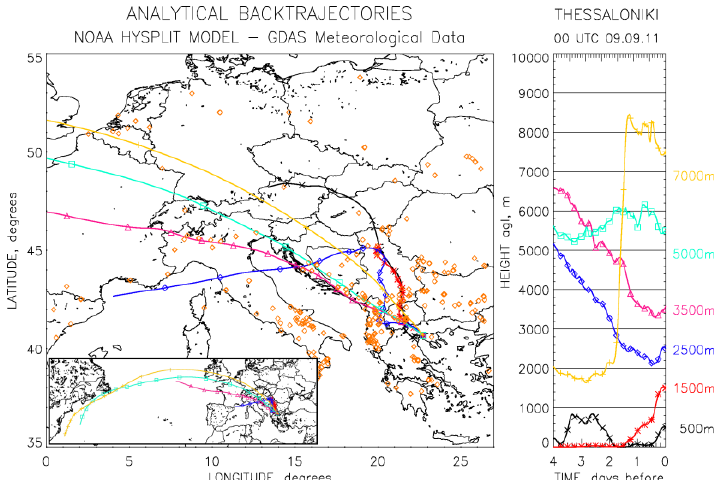
Figure 5. The Hybrid Single-Particle Lagrangian Integrated Trajectory (HYSPLIT) 4-day back-trajectories arriving over Thessaloniki at six different heights at 00:00 UTC on 9 September 2011. Fire spots detected from Moderate Resolution Imaging Spectroradiometer (MODIS)/Terra and Aqua satellite sensors (NASA Fire Information for Resource Management System (FIRMS)) over the area for the same period are overplotted (orange diamonds).